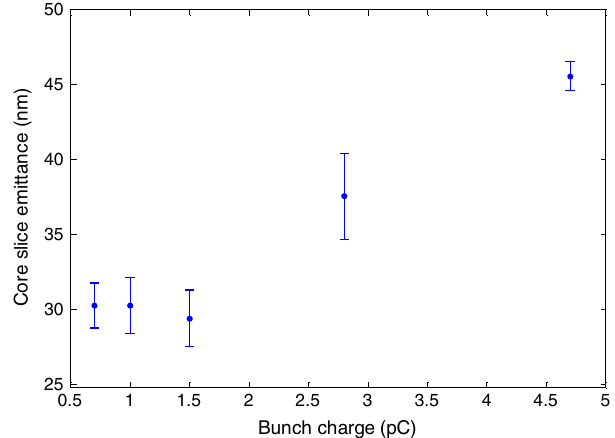
FIG. 2. Measured slice emittance as a function of bunch charge at 262 nm laser wavelength with 50 μ m rms beam size on the cathode to determine the space-charge limit. Measurements at less than 1.5 pC charge give the same core slice emittance values within the accuracy of the measurement, while at higher charge the presence of space-charge effects becomes clear.